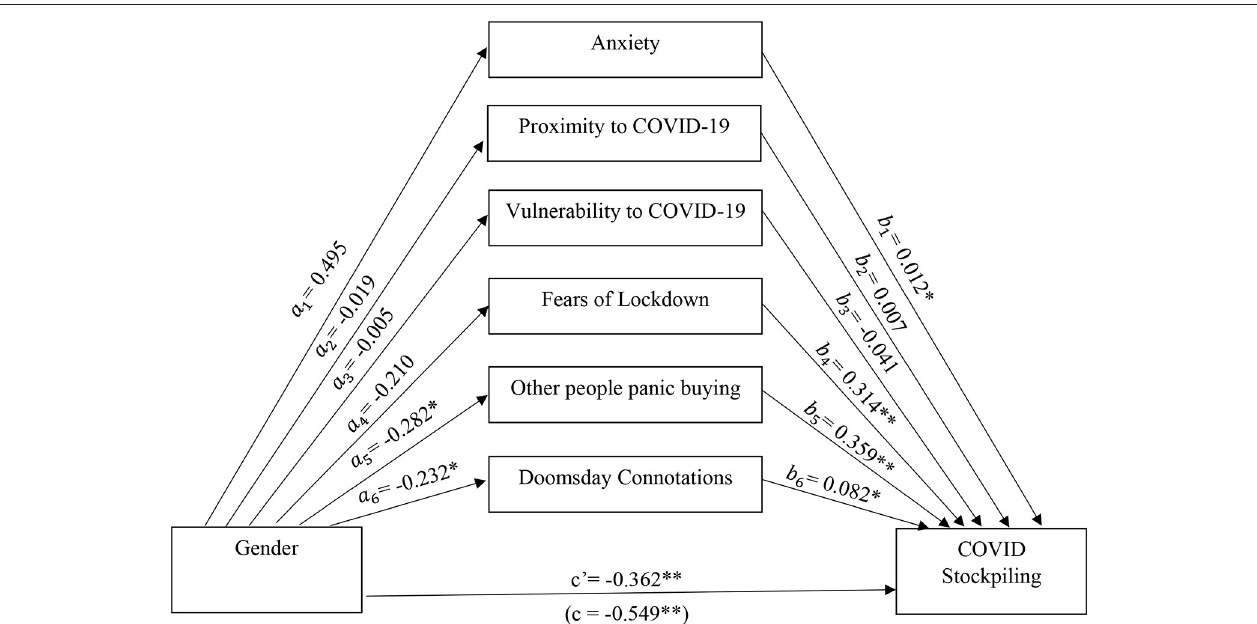
FIGURE 1 | Mediating effects of perceived and actual threat of COVID-19 and social learning on stockpiling ( n = 373). * p < 0.05, ** p < 0.001; a n = effect of gender on variables; b n = effect of variables on COVID stockpiling; c ′ = direct effect of gender on stockpiling; c = total effect of gender on